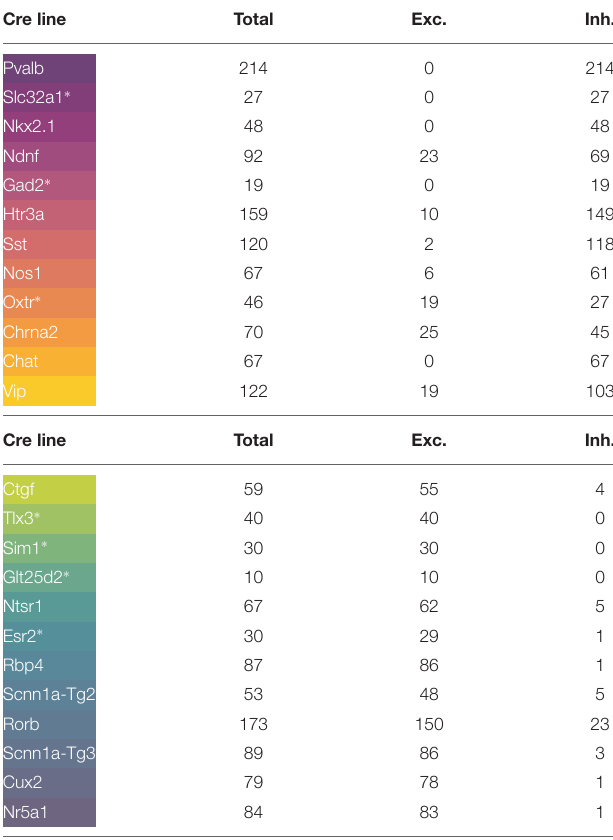
TABLE 1 | Number of cells of each Cre line by neuronal